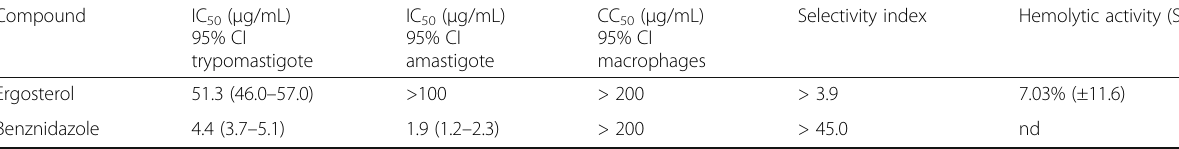
Table 1 Antitrypanosomal activity of ergosterol and cytotoxicity against mammalian cells